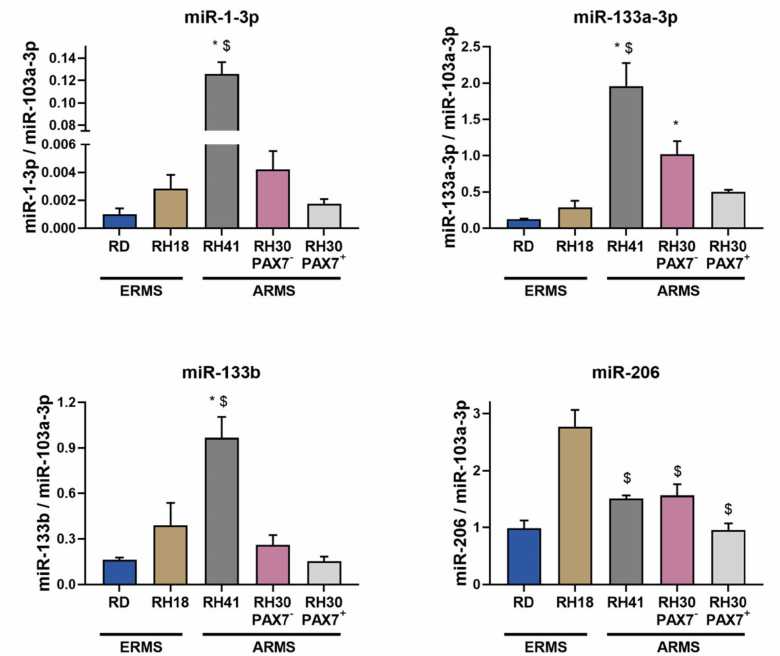
Figure 8. Myogenic microRNAs were differentially expressed in ERMS and ARMS cells. miR-1-3p, miR-133a-3p, miR-133b, and miR-206 expression levels were calculated with 2 − ∆ Ct method using miR-103a-3p as a constitutive gene. The data on graphs show means ± SEM, n = 3–4. Statistical analysis was performed with ANNOVA with Tukey posttest to analyze differences between ERMS and ARMS cell lines. Two types of differences were shown. * symbol indicates statistically significant differences compared to RD ERMS cell lines ( p < 0.05), whereas $ symbol designates statistically significant differences compared to RH18 ERMS cell line ( p <